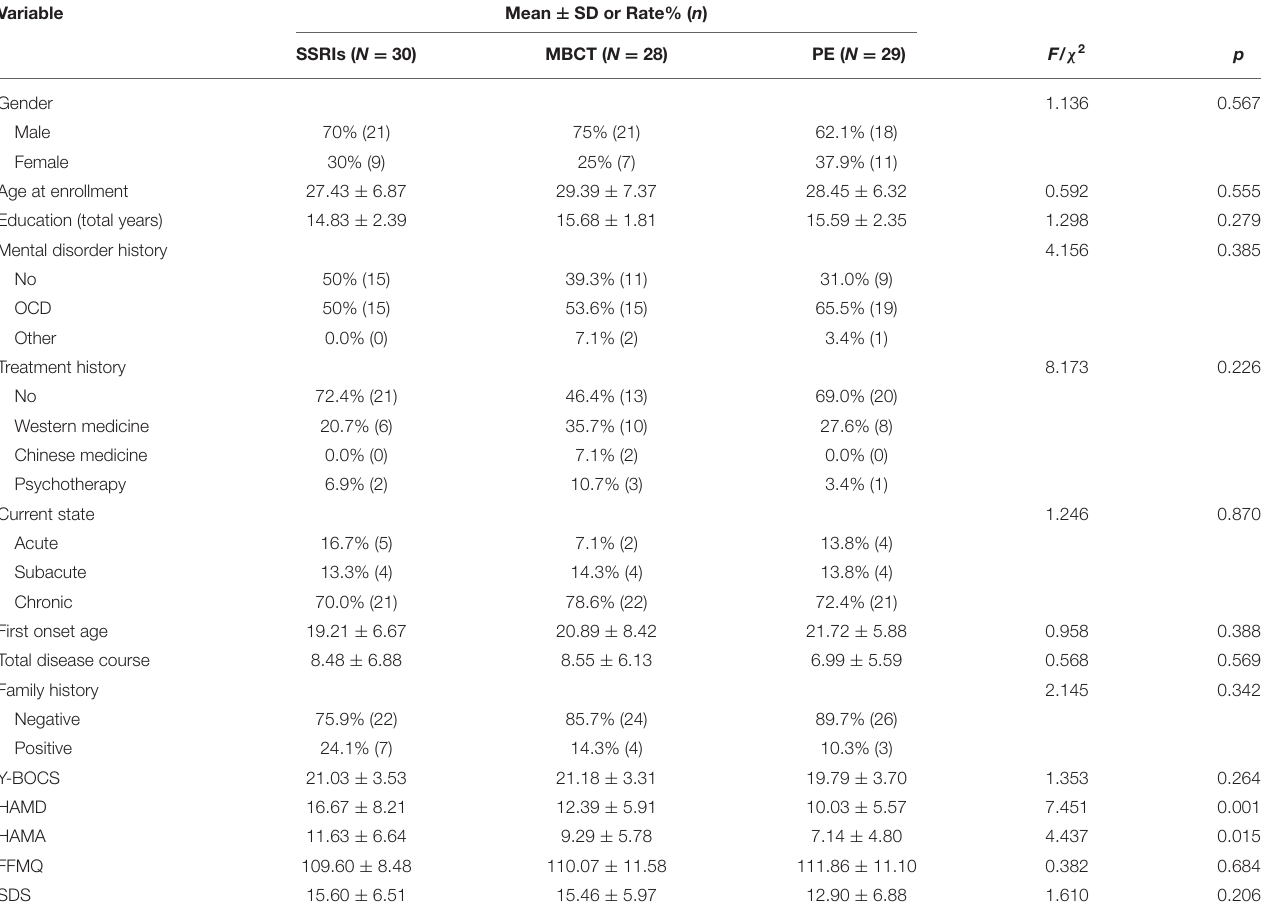
TABLE 1 | Baseline characteristics of the participants.